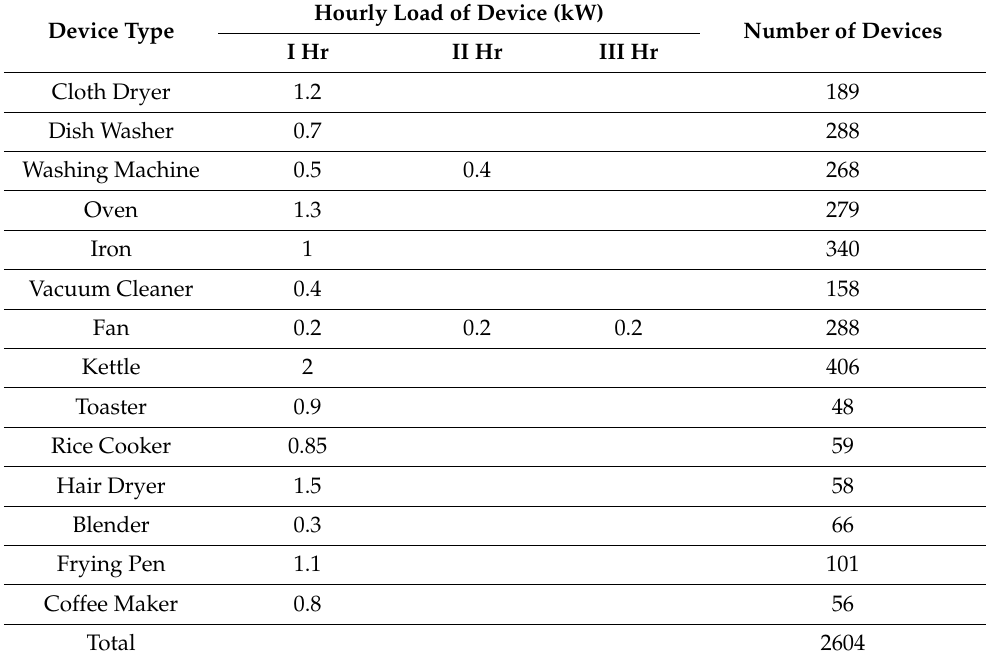
Table 2. Controllable device data in the residential area.